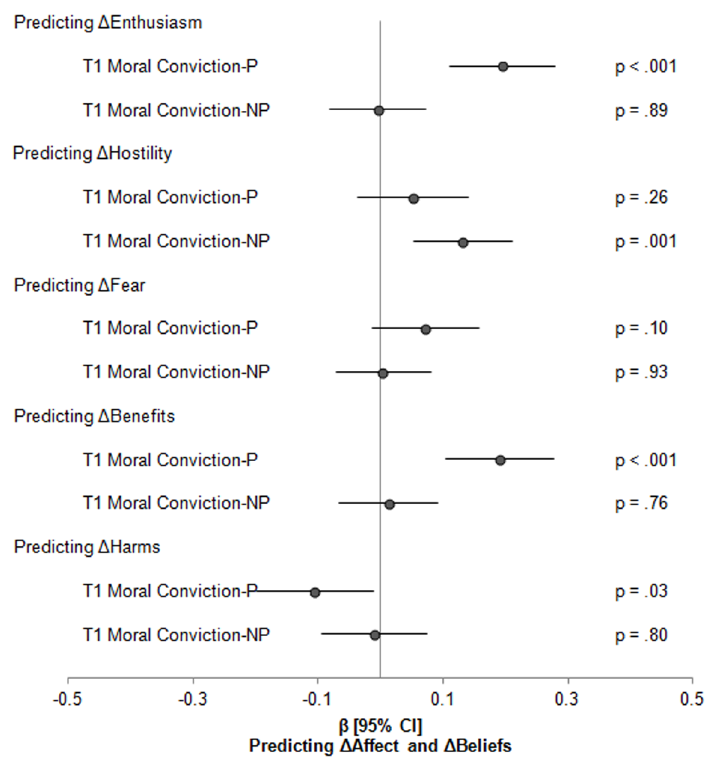
Figure 4. Standardized Estimates, 95% Confidence Intervals, and p-Values of Time 1 Moral Conviction Predicting Time 1 → Time 2 Change in Affect and